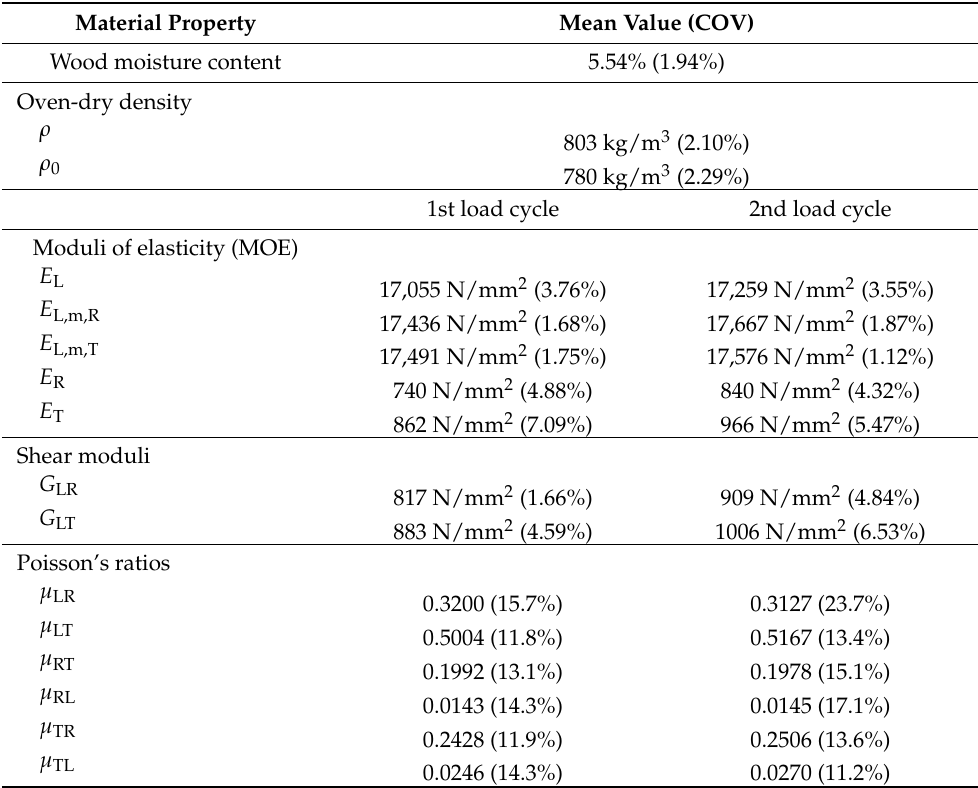
Table 1. Mean values of material properties from bending and compression tests on glulam made of beech laminated veneer lumber GL75 according to ETA-14/0354 [5]. Material Property Mean Value (COV) Wood moisture content 5.54% (1.94%) Oven-dry